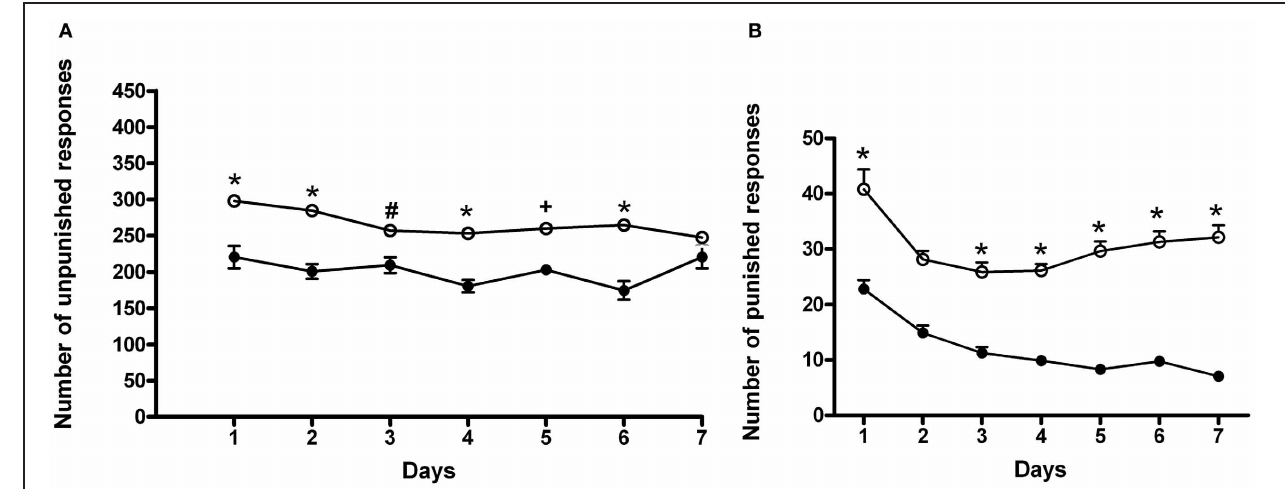
FIGURE 4 | Differences in the number of unpunished (A) and punished (B) responses during the conflict periods in ACD-and in water-drinking rats. Each value represents the means ± S.D. of 16 rats. # p < 0 . 05; + p < 0 . 01; ∗ p < 0 . 001 vs. control groups. ( ) CTR, ( ) ACD.